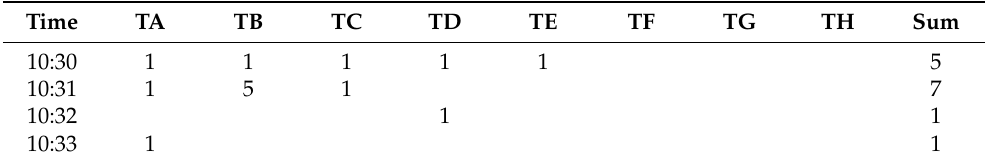
Table 2. Sample data collected at workplace A during the observation of 1 person.